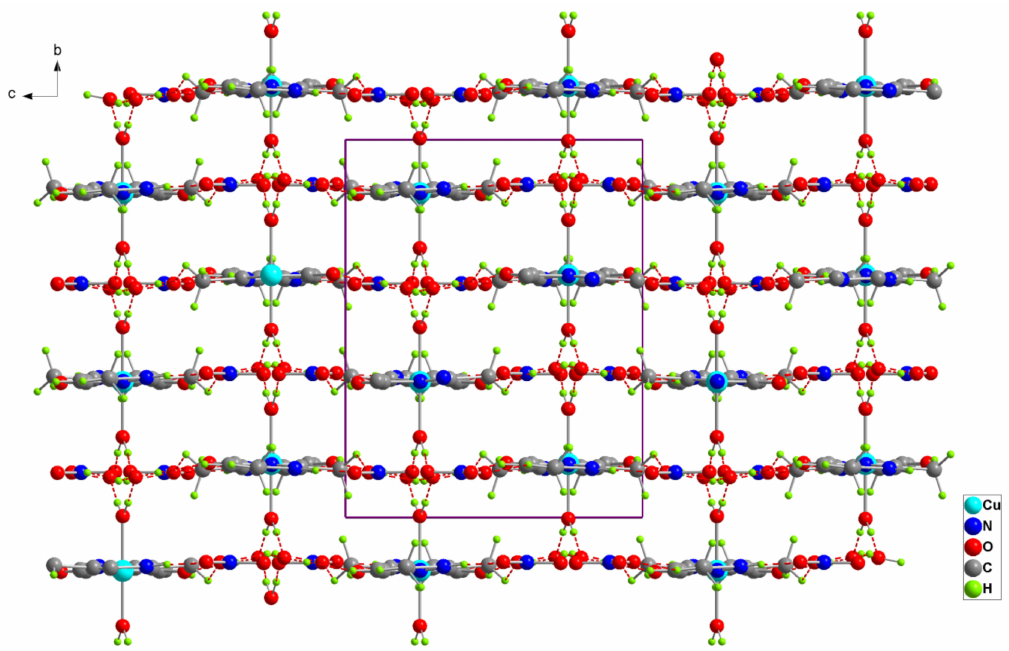
Figure 3. Projection of the structure of ( 1 ) along the a-axis. Dotted lines indicate hydrogen